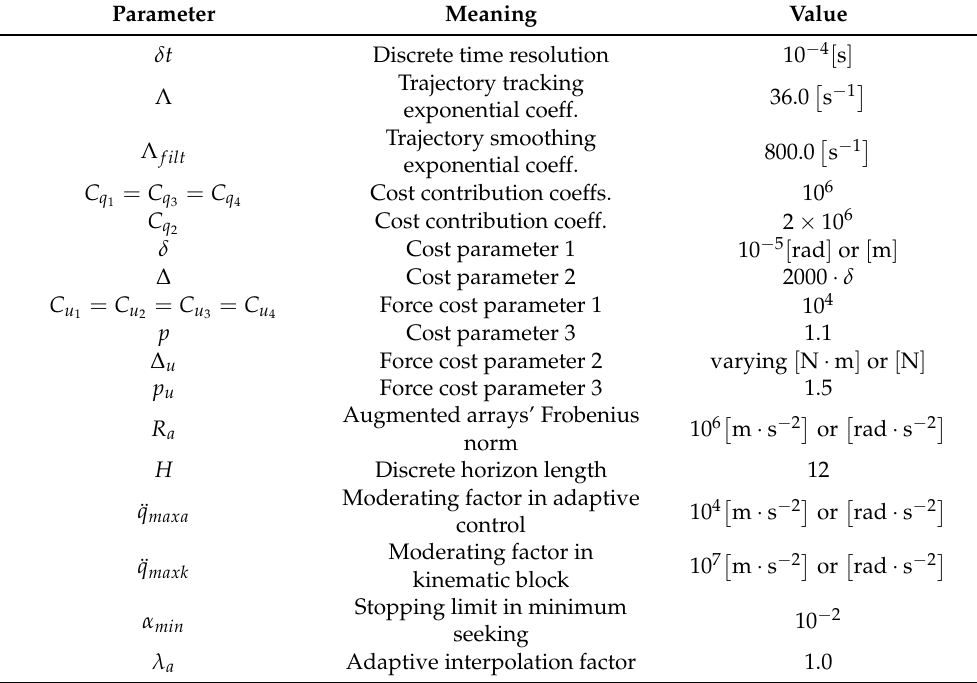
Table 2. The Controller’s